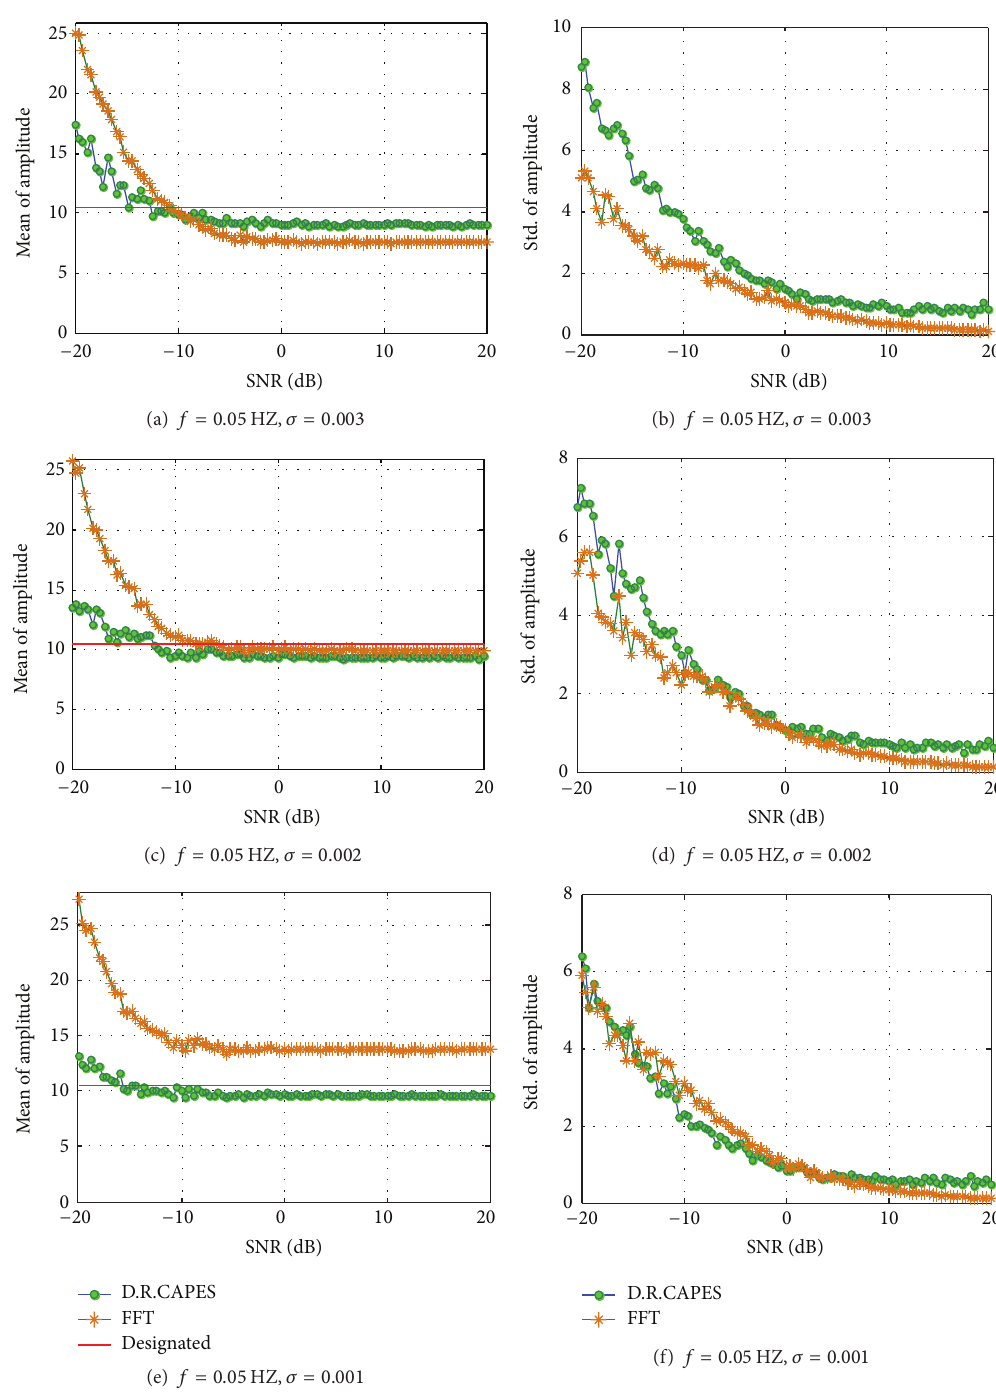
Figure 7: Influence of noise on the identified amplitude spectrum, that is, mean and standard deviation. ((a), (b) mode 1, 𝜎 = 0.003 ; (c), (d) mode 2, 𝜎 = 0.002 ; (e), (f) mode 3, 𝜎 = 0.001 ).